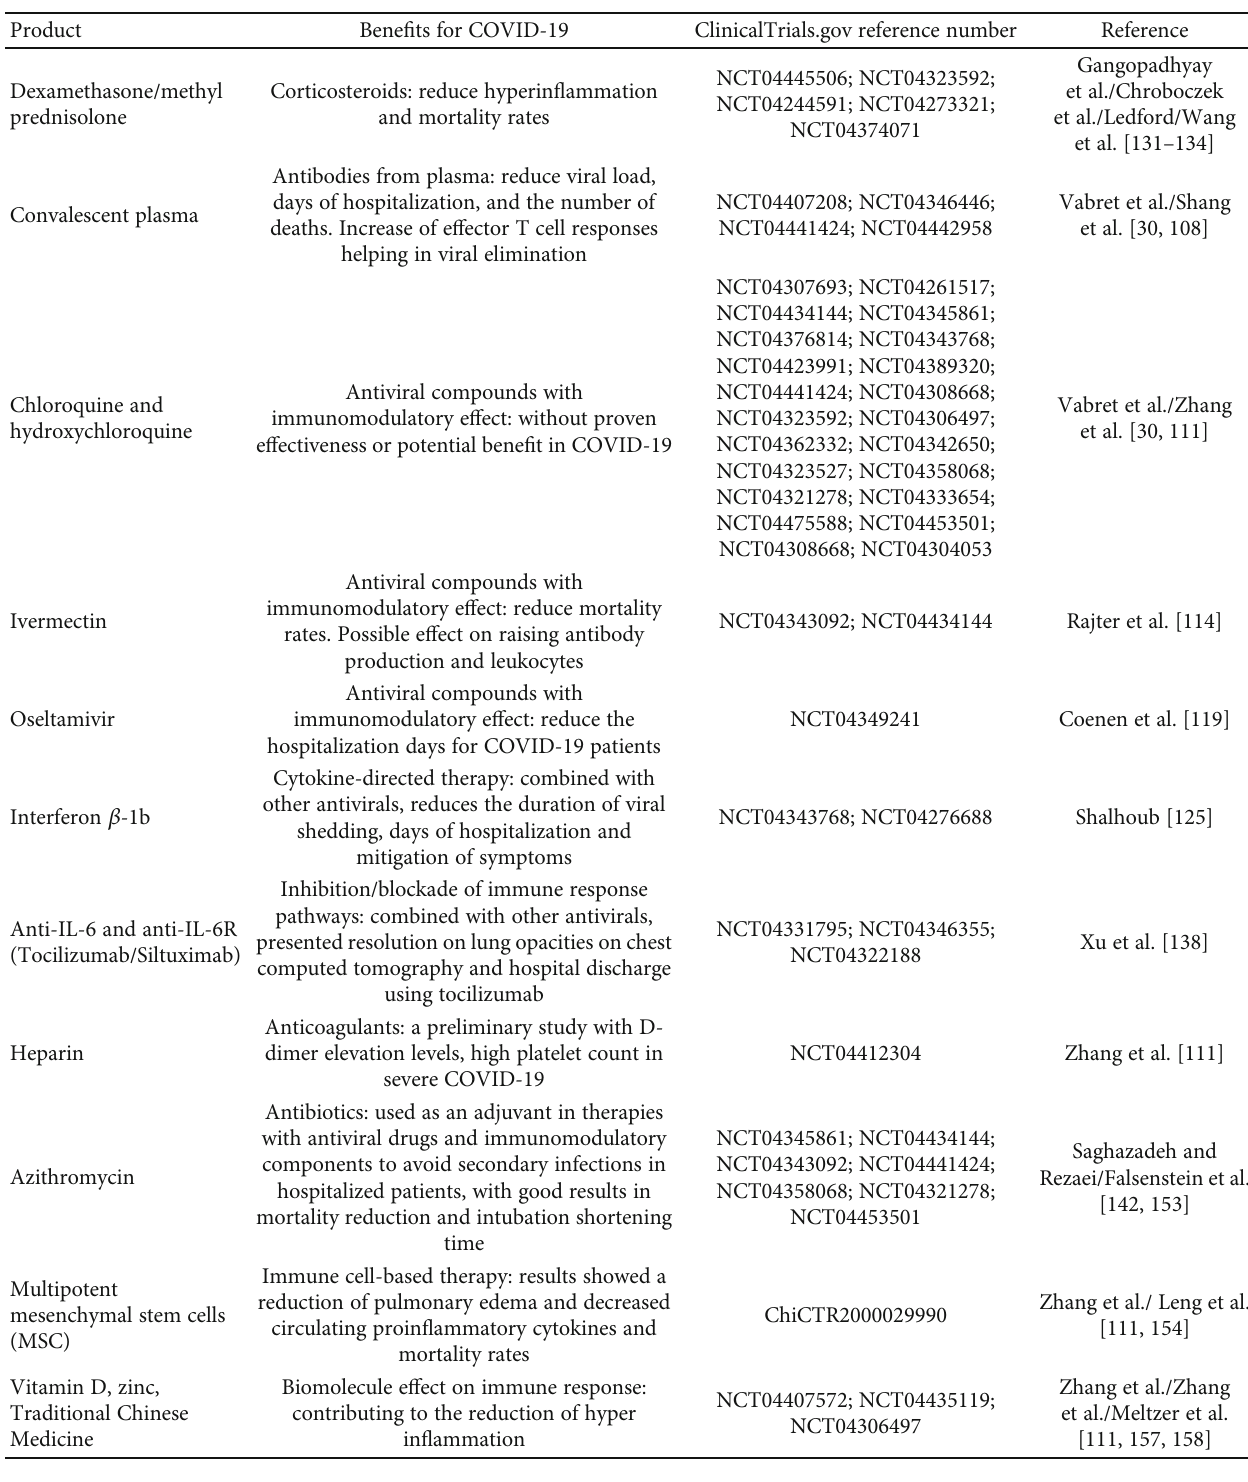
Table 1: Clinical trials with results disclosure and ongoing clinical trials focused on immunotherapy to attempt immune regulation during